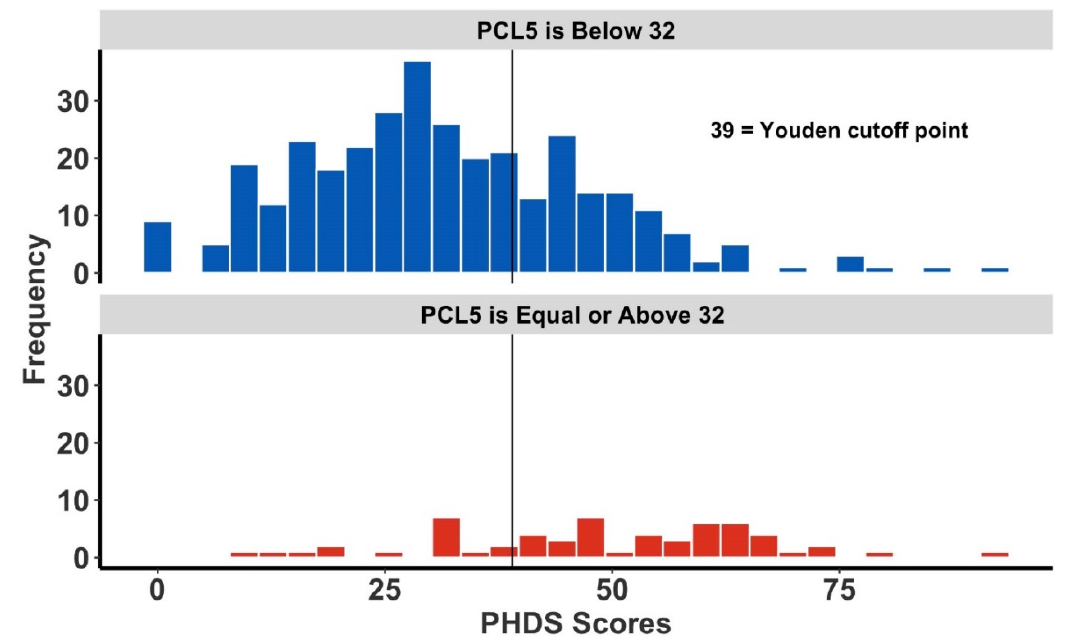
Figure 2. The frequency of Post-Hurricane Distress Scale (PHDS) scores and Generalized Anxiety Disorder (GAD-7) scores. The overlaid vertical line represents the GAD-7-specific Youden cutoff point. The upper figure (in blue) is all respondents scoring below 7 on the GAD-7, while the figure below (in red) represents individuals deemed high-risk for GAD, having a GAD-7 score of 7 or more.